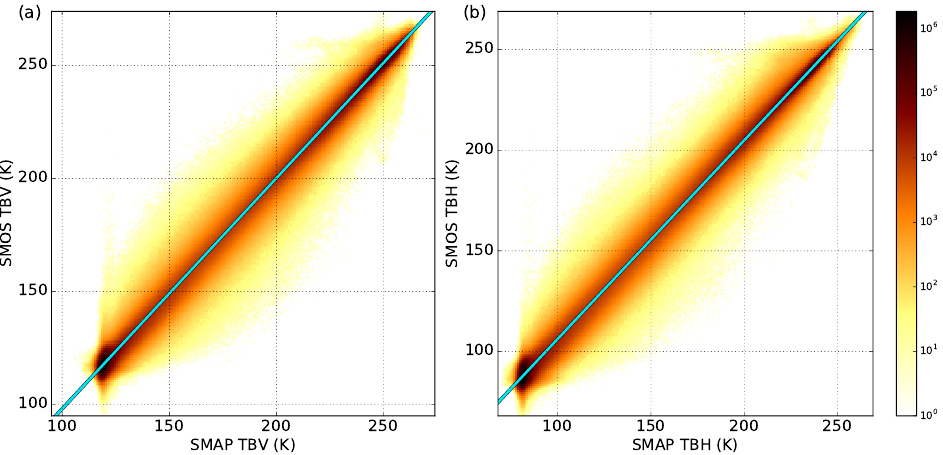
Figure 10. Two-dimensional histogram of vertically ( a ) and horizontally ( b ) polarized TBs from SMAP and SMOS over the Arctic ocean region north of 50 ◦ N for the 2-year period from 1 April 2015 to 31 March 2017. Blue lines indicate the respective regression